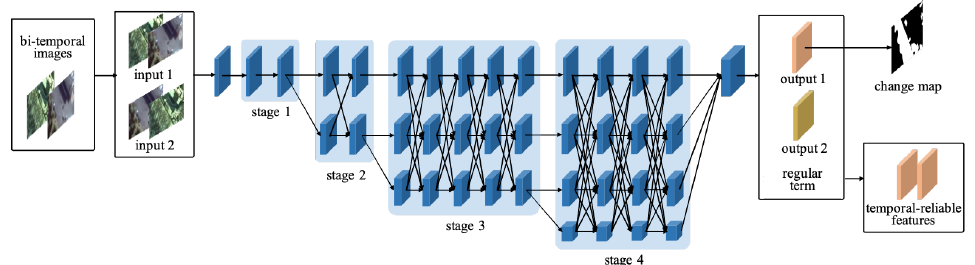
Figure 5. Framework of the proposed TRCD. Input1 and input2 are combinations of bi-temporal images at different sequences. Features of different spatial resolutions will perform multiple infor- mation interactions in the same stage. The classification loss is calculated between output1 and the change map. The regularization loss is calculated between output1 and output2.